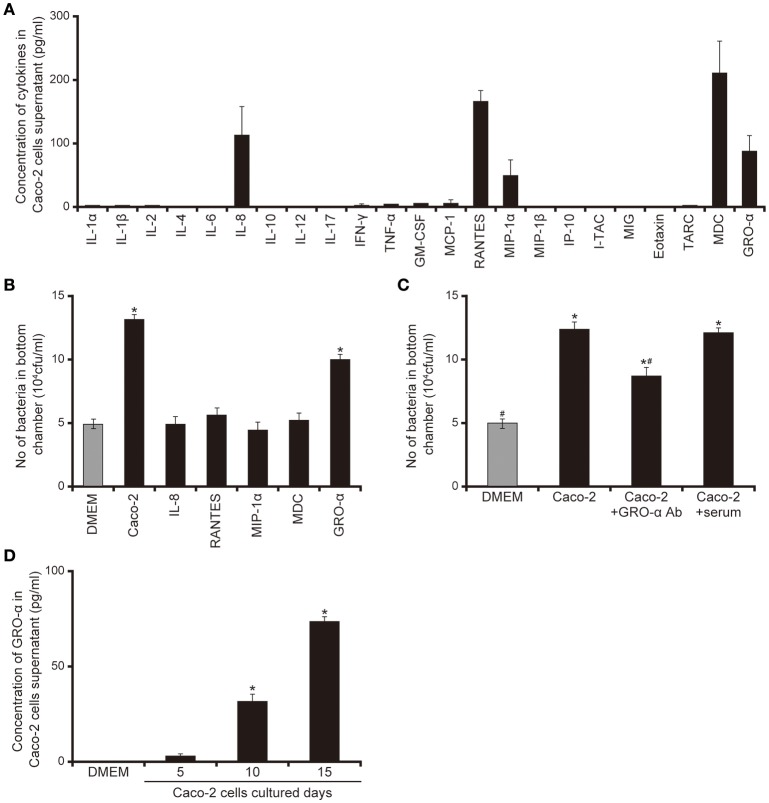
Chemokines secreted by Caco-2 cells facilitate the penetration of the P. aeruginosa PAO1 strain through the mucin layer. (A) Cytokine levels in the 15-day Caco-2 cell supernatant were determined by enzyme-linked immunosorbent assay (ELISA). The graph shows the cytokine concentrations in the supernatant. Error bars indicate standard error (n = 3). (B) The cytokines identified by the assay were placed in the bottom chamber of Transwell, as were unfiltered 15-day Caco-2 cell supernatant and Dulbecco's modified Eagle medium (DMEM; control). The P. aeruginosa PAO1 strain was added to the top chambers and, after 3 h, the numbers of bacteria in the bottom chamber were counted. Error bars indicate standard error (n = 3). *P < 0.05 compared with DMEM. (C) Caco-2 cells supernatant were pretreated for 30 min with anti-GRO-α antibodies (GRO -α Ab) (1 ml of Caco-2 cells supernatant/100 ng of antibody) or normal goat serum (serum) then inoculated onto the bottom chamber of Transwell. Error bars indicate standard error (n = 3). *P < 0.05 compared with DMEM. #P < 0.05 compared with Caco-2 cell supernatant. *#P < 0.05 compared with DMEM and P < 0.05 compared with Caco-2 cell supernatant. (D) Growth regulated oncogene-α concentrations in the 5-, 10-, and 15-day Caco-2 cell supernatants were determined by ELISA. Error bars indicate standard error (n = 3). *P < 0.05 compared with DMEM.